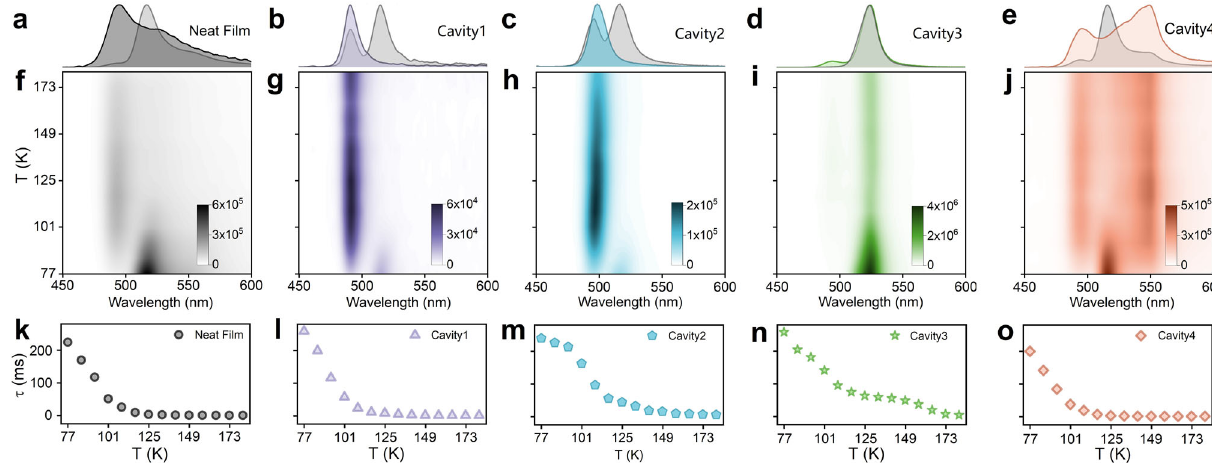
Fig. 3 Temperature dependent steady state and time resolved delayed emission. a – e Normalized gated emission (gate delay 100 ns) at 181 K (colored shaded areas) and 77 K (gray shaded areas). f – j Temperature-dependent gated emission (gate delay 100 ns). The emission from Cavity 3 is approximately an order of magnitude larger than for the others. k – o , Temperature-dependent lifetimes of delayed emission.